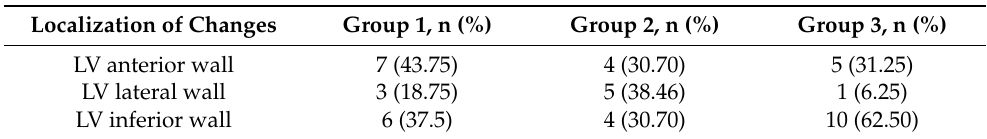
Table 1. Distribution of patients in the studied groups depending on localization of changes by leads in which fQRS was registered.